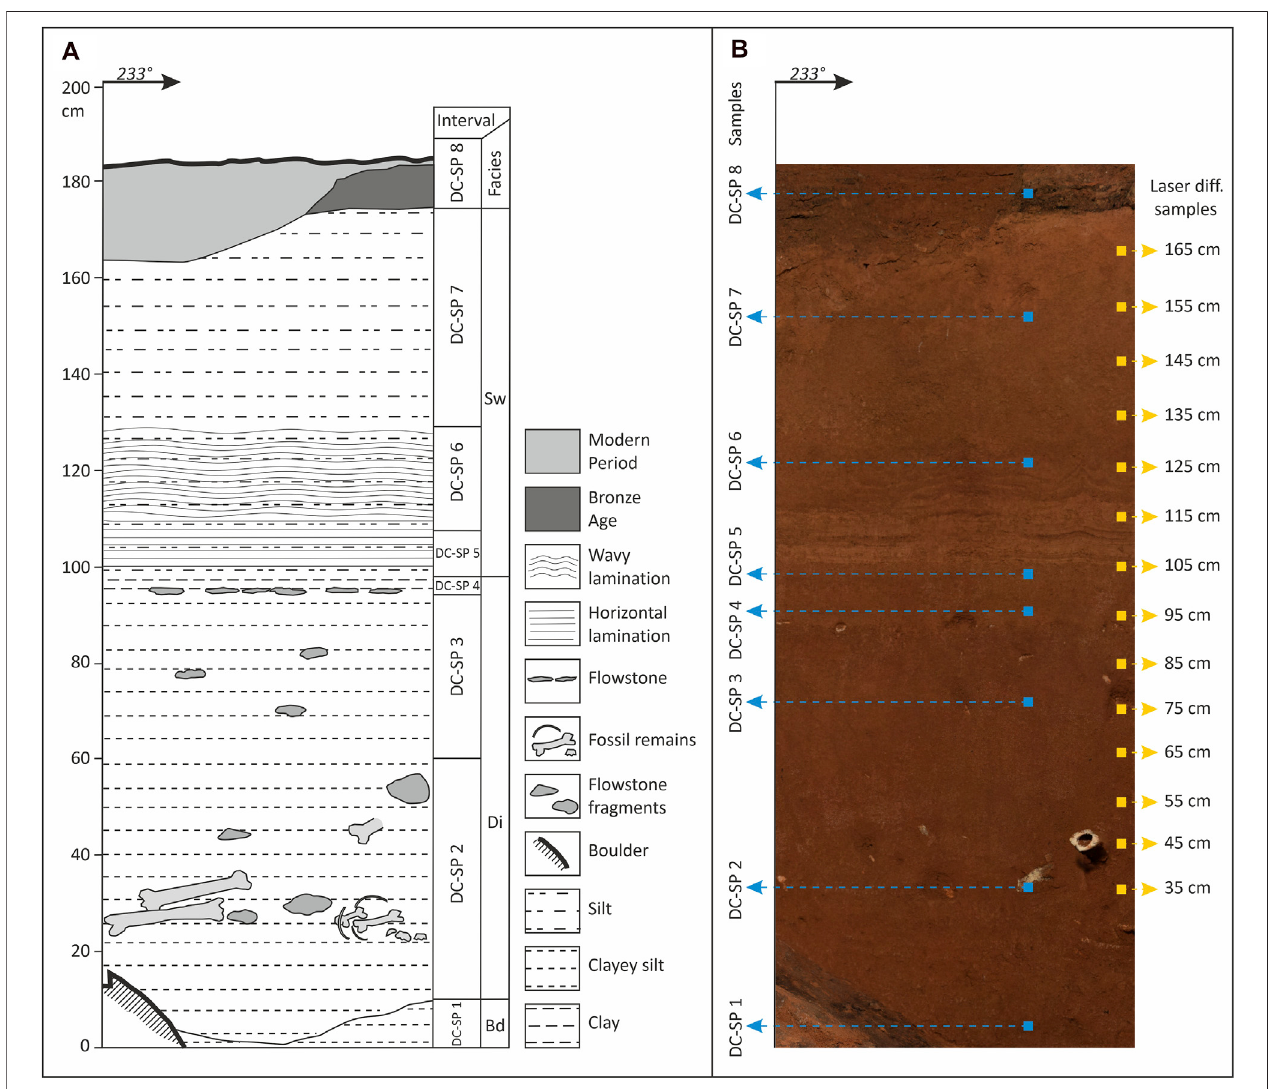
FIGURE 3 | Sedimentary log and photo of the investigated pro fi le DC-SP within the archaeological excavation site in the Lower Cerova ˇ cka Cave (A) Sedimentary log with indicated main structural and lithological features, (B) photo of pro fi le and indicated position of sampling spots (on the left side — bulk analysis of described intervals; on the right side — high-resolution granulometric